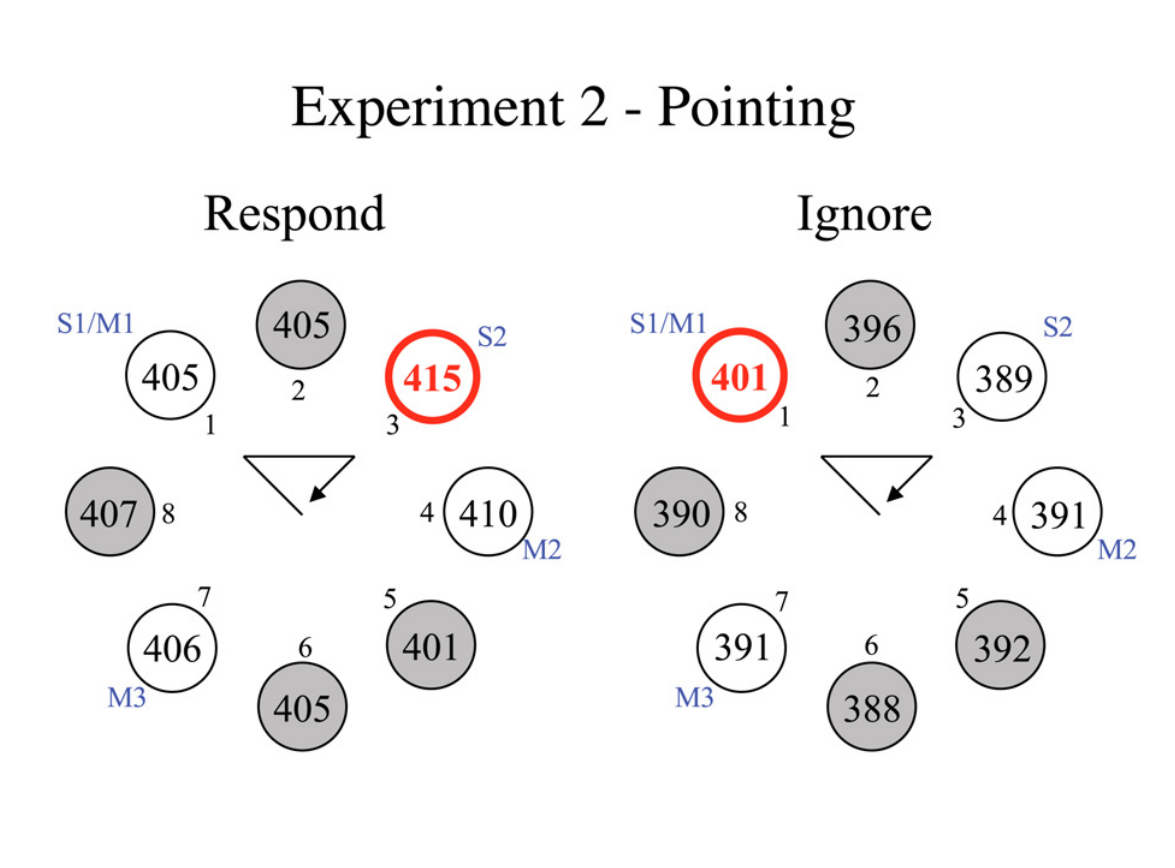
FIGURE 5. Mean of median manual RT in the Respond and Ignore conditions of Experiment 2. Formatting is the same as in Fig.